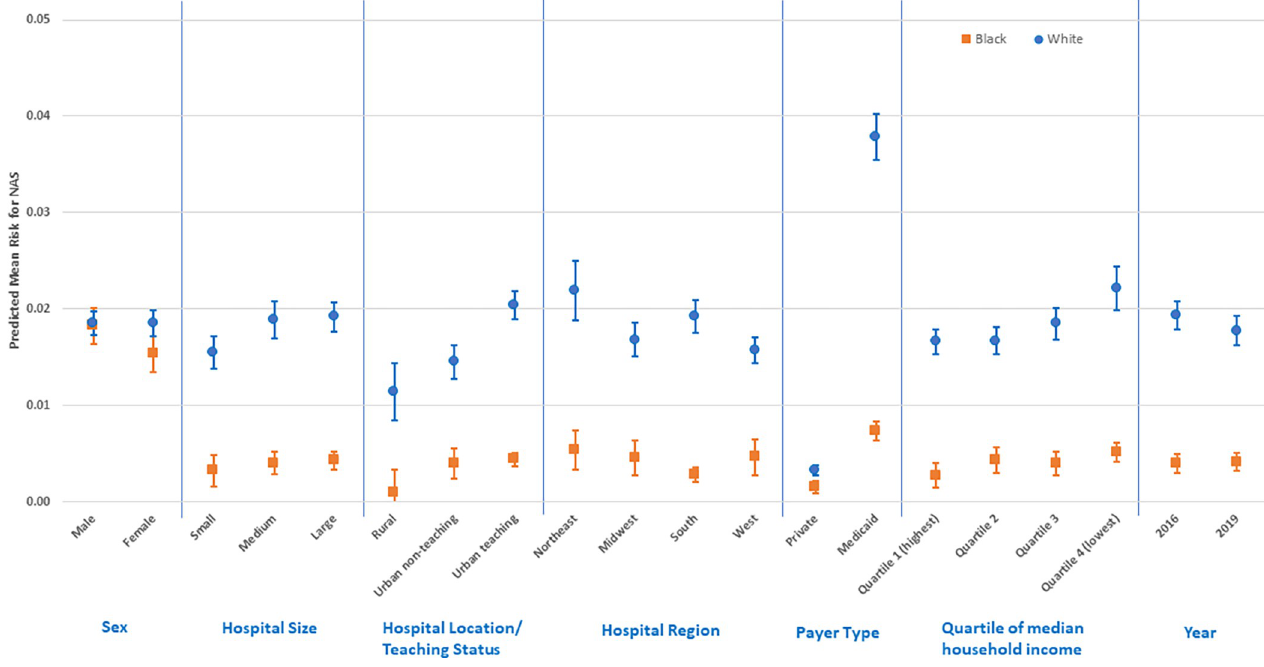
Fig 1. Predictive margins for factors related to the White/Black NAS disparity (risk differences and 95% confidence intervals).